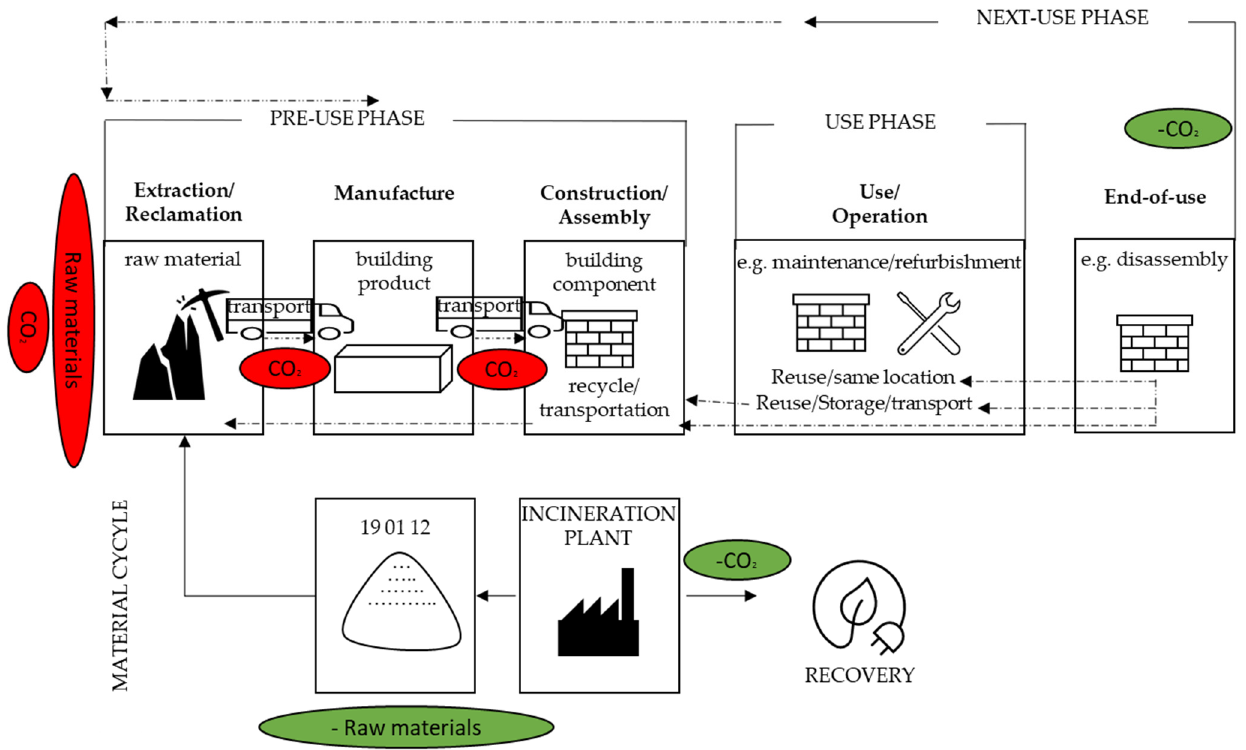
Figure 4. Circular economy of 19 01 12 and old buildings materials. CO 2 savings and CO 2 emissions during the material cycle and circular economy process.